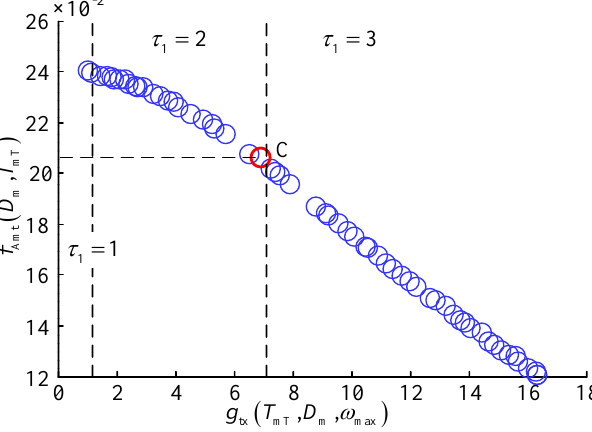
Figure 4. Pareto front-end individual distribution of objective. Table 1 shows the comparison of parameter design results of electric tractor drive motors. The single-objective optimal design scheme of η me optimal and η tr optimal was used as the control